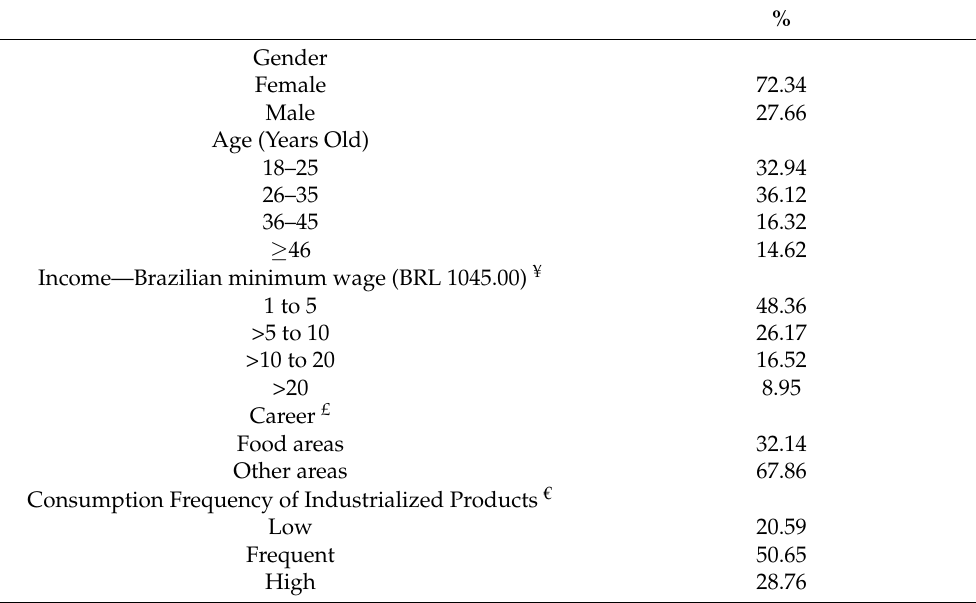
Table 1. Information concerning socioeconomic characteristics and consumption frequency of indus- trialized products of the participants ( n =